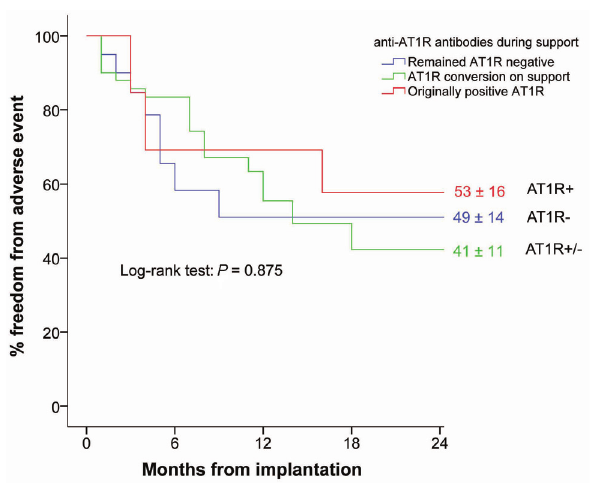
Fig. 3. Freedom from Heart Mate II post – implantation adverse events (device malfunction, major bleeding, major infection and neurologic dysfunction).